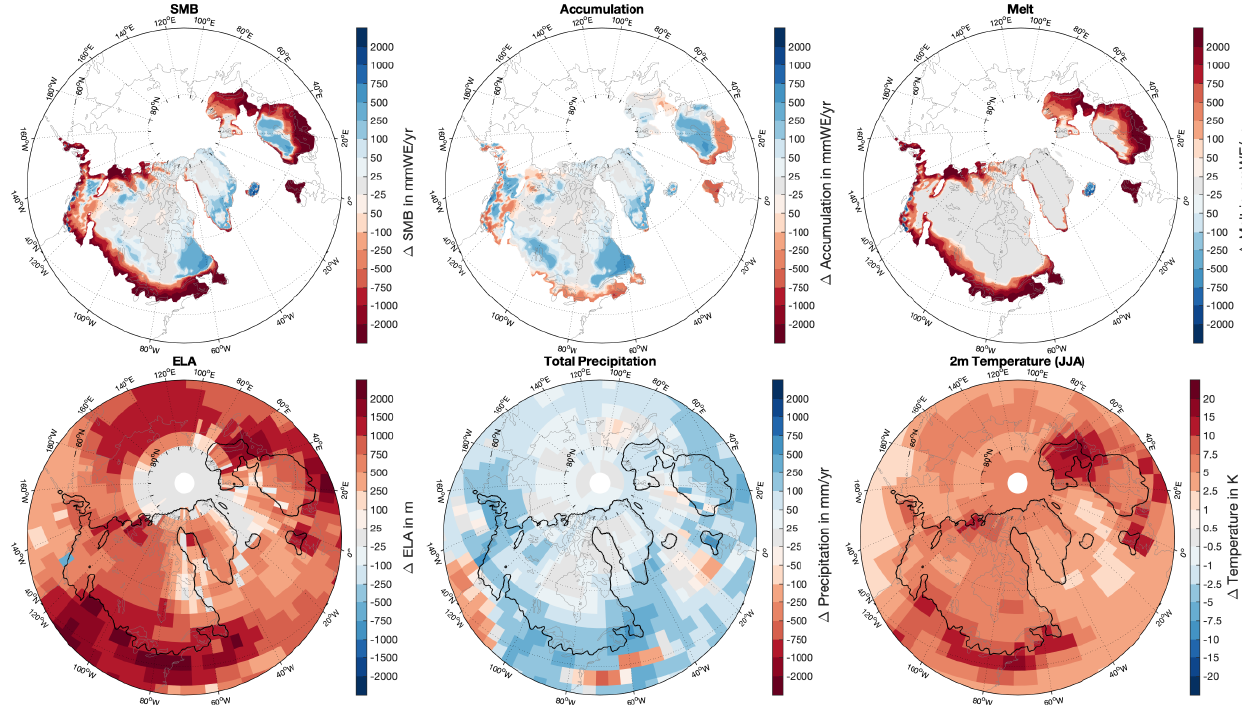
Figure A3. Similar to Fig. 5 but for differences between 15ka and LGM from MPI-ESM-CR Ice6G .